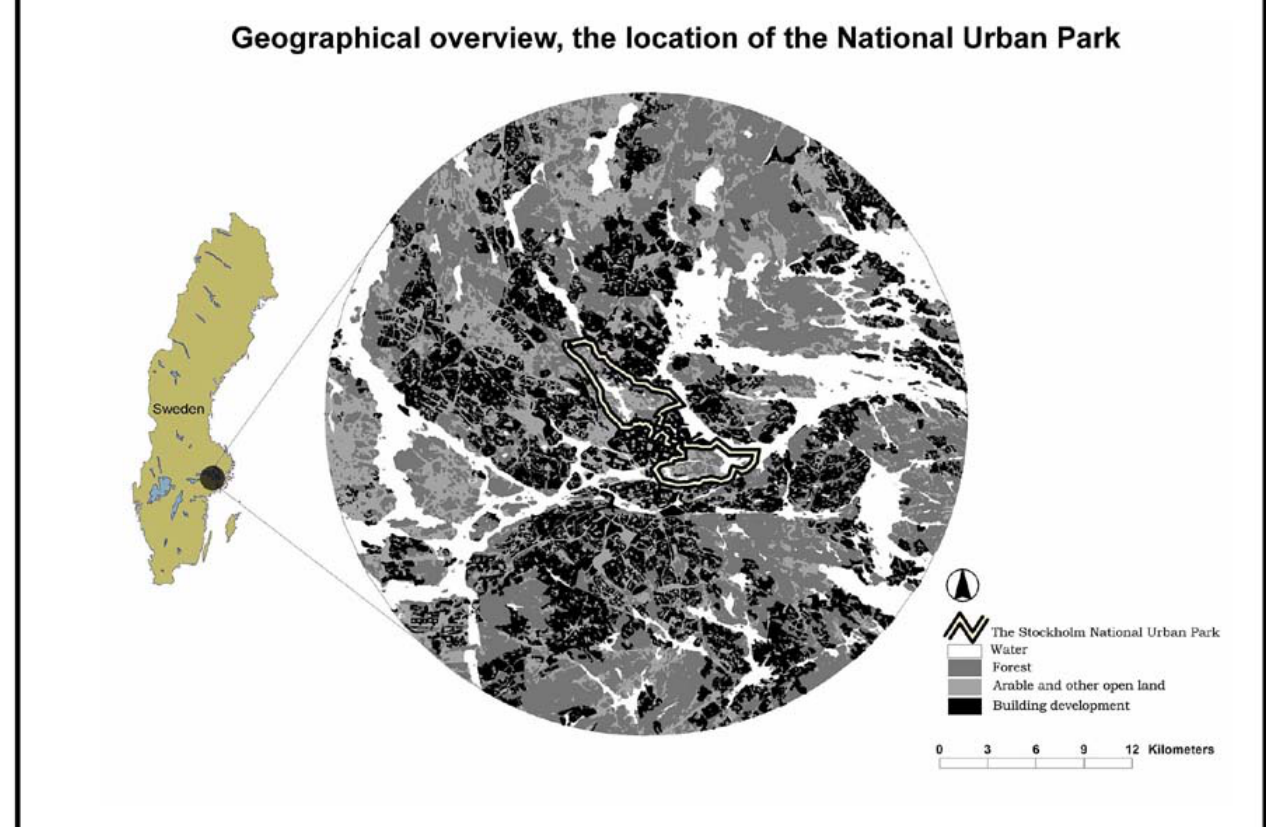
Fig. 4. Geographical